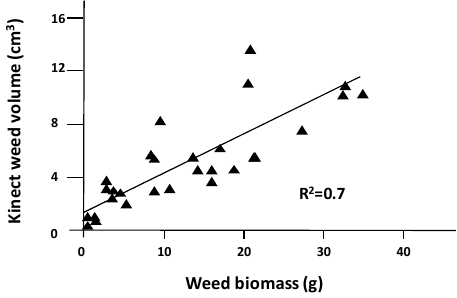
Figure 6. Simple linear regression between the total weed volume that was calculated with the depth and color images and the weed biomass weight.